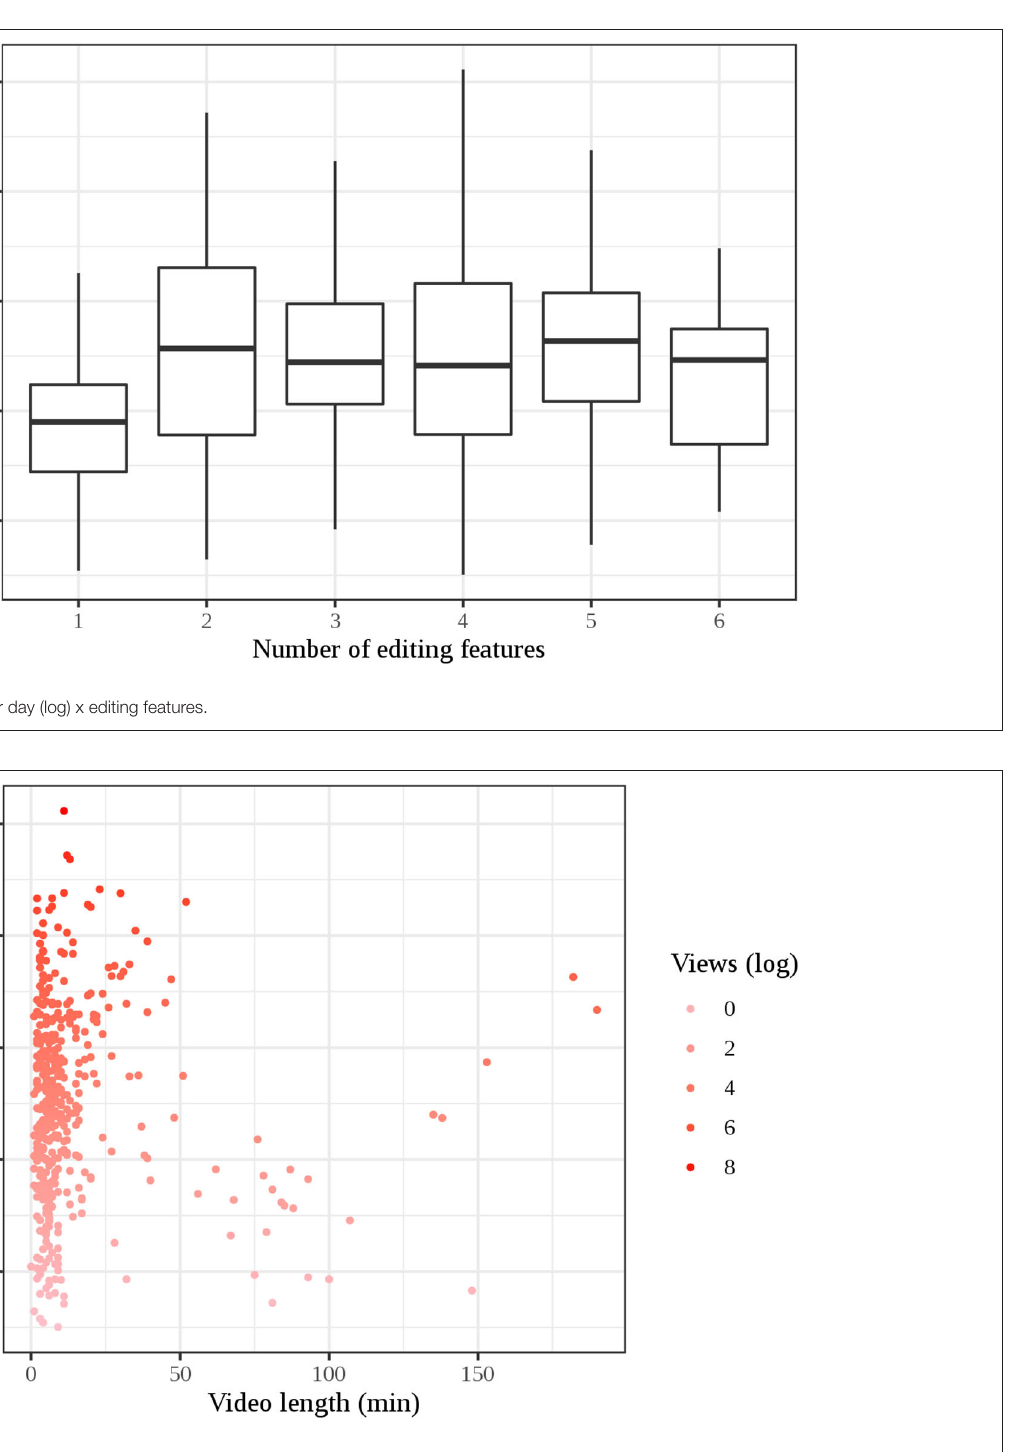
FIGURE 4 | Number of views per day (log) x video length